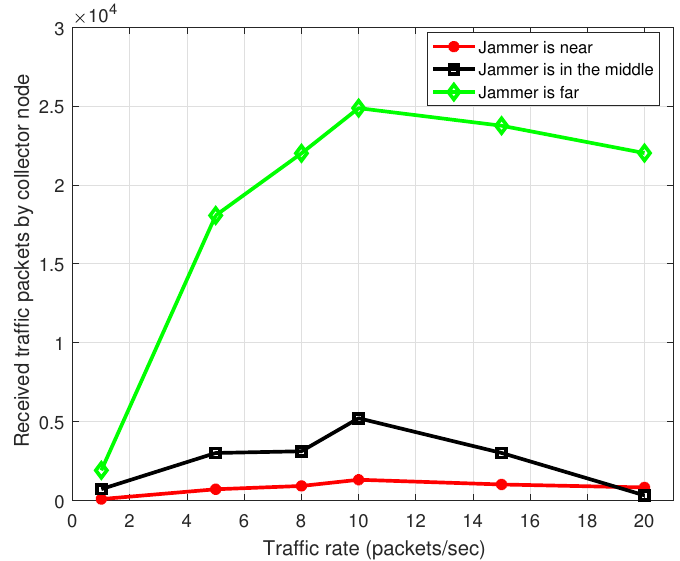
Figure 16. System throughput with jamming, the jammer node is located near, in the middle and far from the collector node. Links have packet